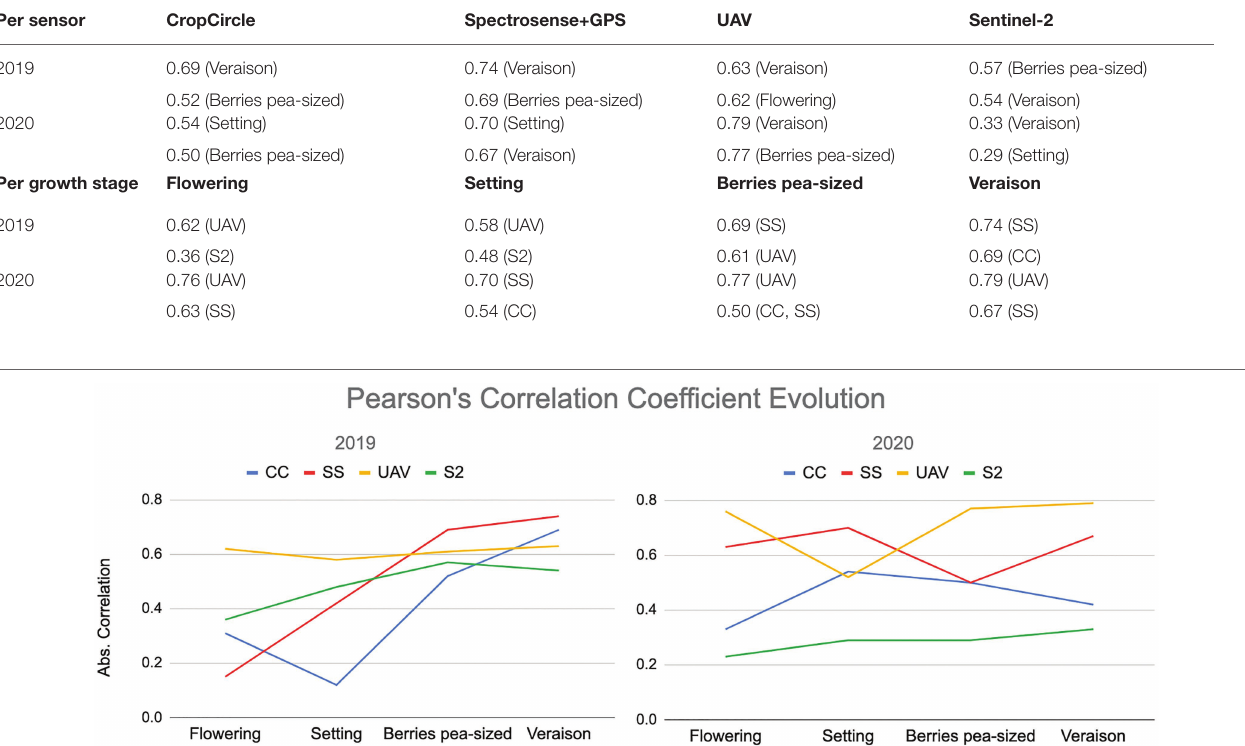
TABLE 3 | Selected best performed Pearson’s correlation coefficients comparisons between NDVI data from all four proximal and remote sensors and total soluble solids (i) for a given sensor (rows 1 and 2) and (ii) for given growth stages of the season (rows 3 and 4; CC, CropCircle; SS, Spectrosense+GPS; UAV; and S2, Sentinel-2).